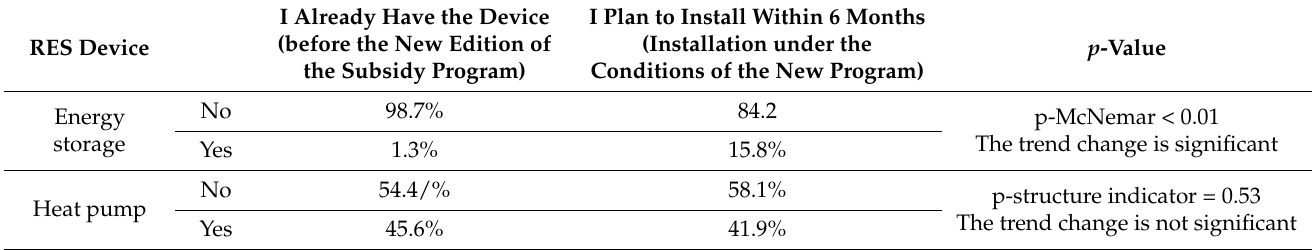
Table 3. Analysis result for the McNemar test for the energy storage and the test for the structure indicator for heat